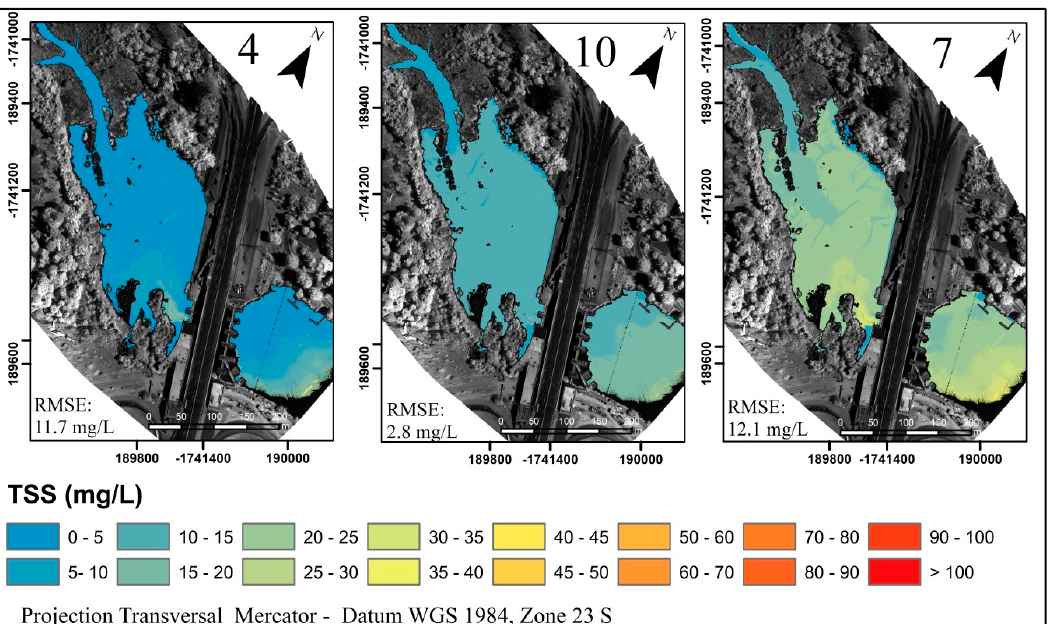
Figure 16. Field and estimated total suspended solids (TSS) concentrations for the 2018/09/12 survey in the Paranoá reservoir, for different models using the near-infrared (NIR), green and red bands of